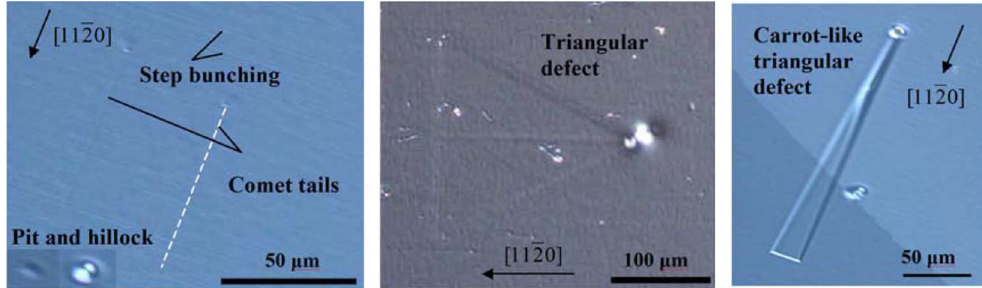
Figure 15. Microscopic image of the morphological defects revealed after KOH etching in n-type 4H-